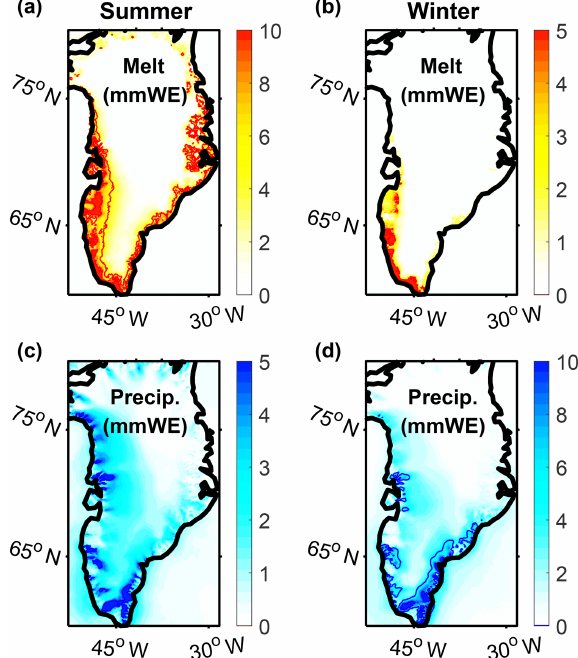
Figure 9. Composites of (a, b) the surface melt anomalies, relative to the climatological monthly means, and (c, d) the total precipita- tion during summer and winter melt events (in millimeters of water equivalents), averaged from day 0 to day 2, obtained from the re- gional climate model MAR, with contours indicating the 5mm WE